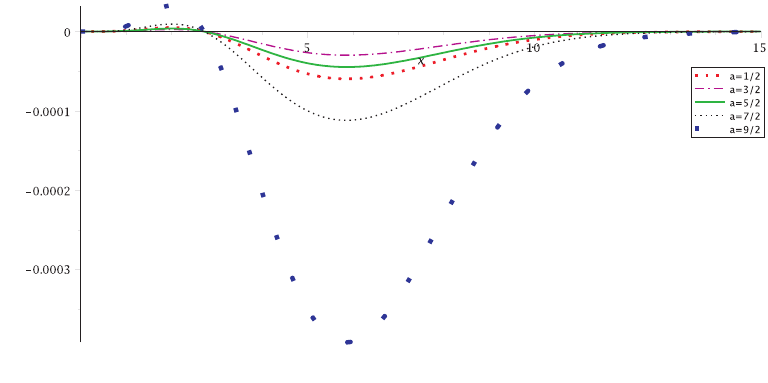
Figure 14: Absolute error.